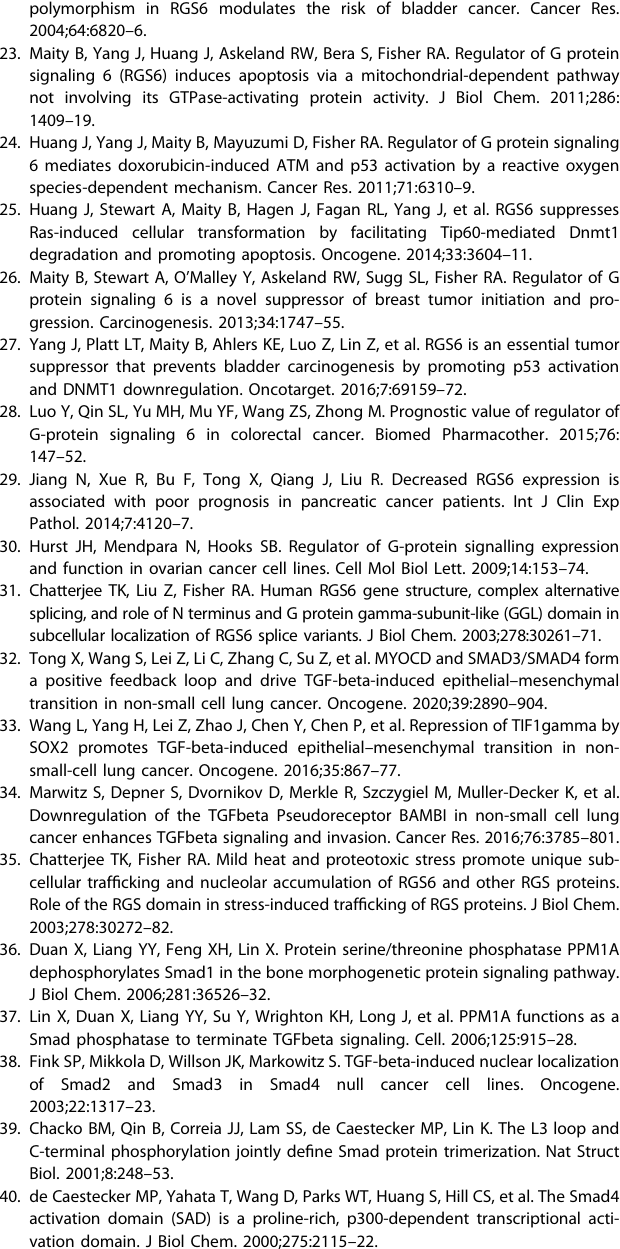
Fig. 7 Interaction between RGS6 and SMAD4 is mediated via association between the GGL domain and the MH2 domain. A Upper, schematic illustration of RGS6 mutants. Lower, 293 T cells were co-transfected with Flag-tagged SMAD4 and various HA-tagged RGS6 mutants. Cell lysates were collected and subjected to IP with anti-HA antibody and probed for indicated proteins. B Upper, schematic illustration of SMAD4 mutants. Lower, 293 T cells were co-transfected with HA-tagged RGS6 and various Flag-tagged SMAD4 mutants. Cell lysates were collected and subjected to IP with anti-Flag antibody and probed for indicated proteins. C A549 cells transfected with different RGS6 mutants were treated with or without TGF- β (5 ng/ml) for 2 h. Cell lysates were collected and subjected to qRT-PCR for detection of Snail mRNA level (** p < 0.01, *** p < 0.001). D A549 cells transfected with different RGS6 mutants were treated with or without TGF- β (5 ng/ml) for 24 h. Cell lysates were collected and subjected to immunoblotting for indicated proteins. E Schematic diagram summarizing the effects of RGS6 on